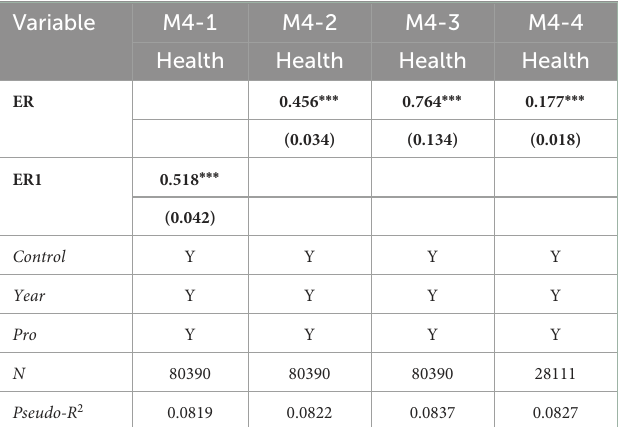
TABLE 4 Results of robustness test.